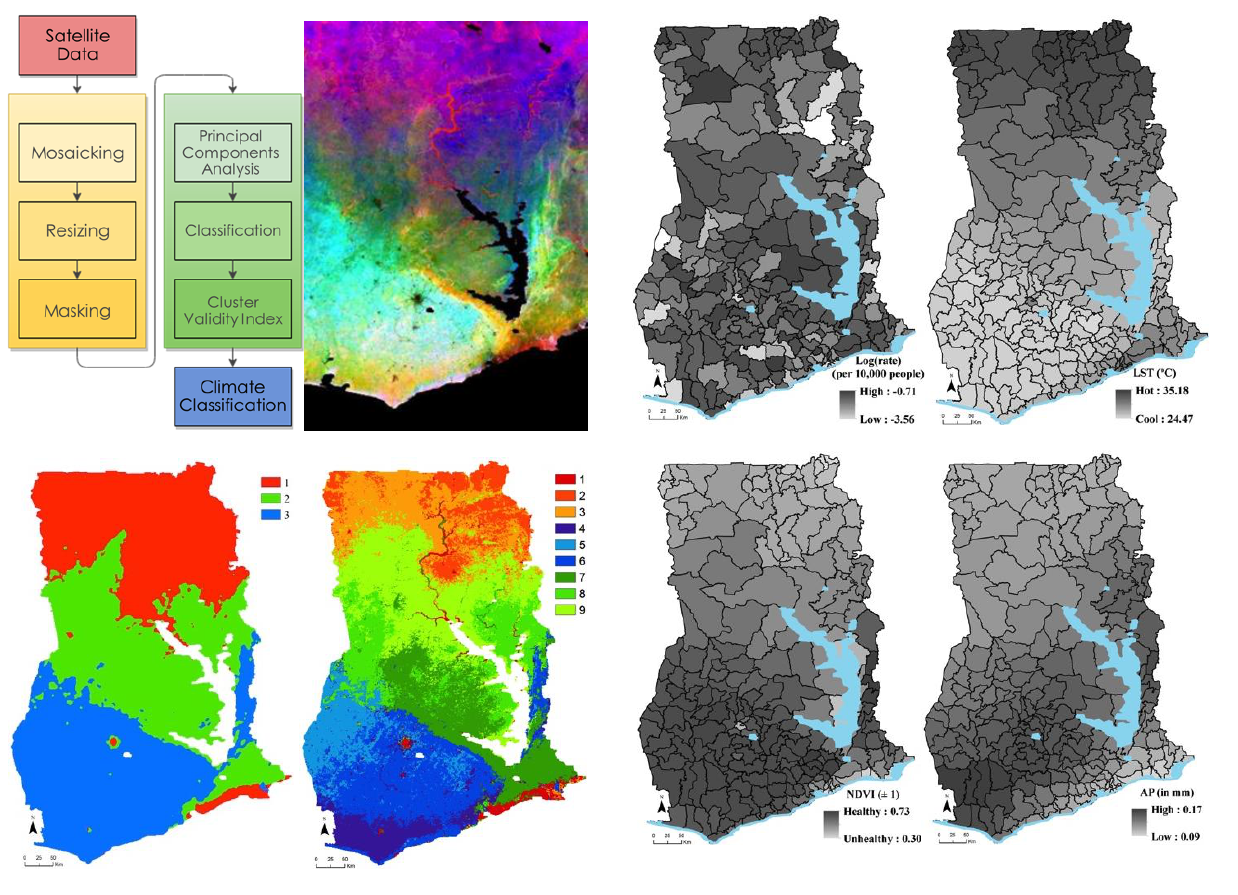
Figure 2: Spatial distribution of the 8 year averages of Log e (rate), LST, NDVI, and AP aggregated from 2008-2015 and extracted by the 216 districts of Ghana. Districts with no counts for the entire time period are shown in white, and data values were stretched from high to